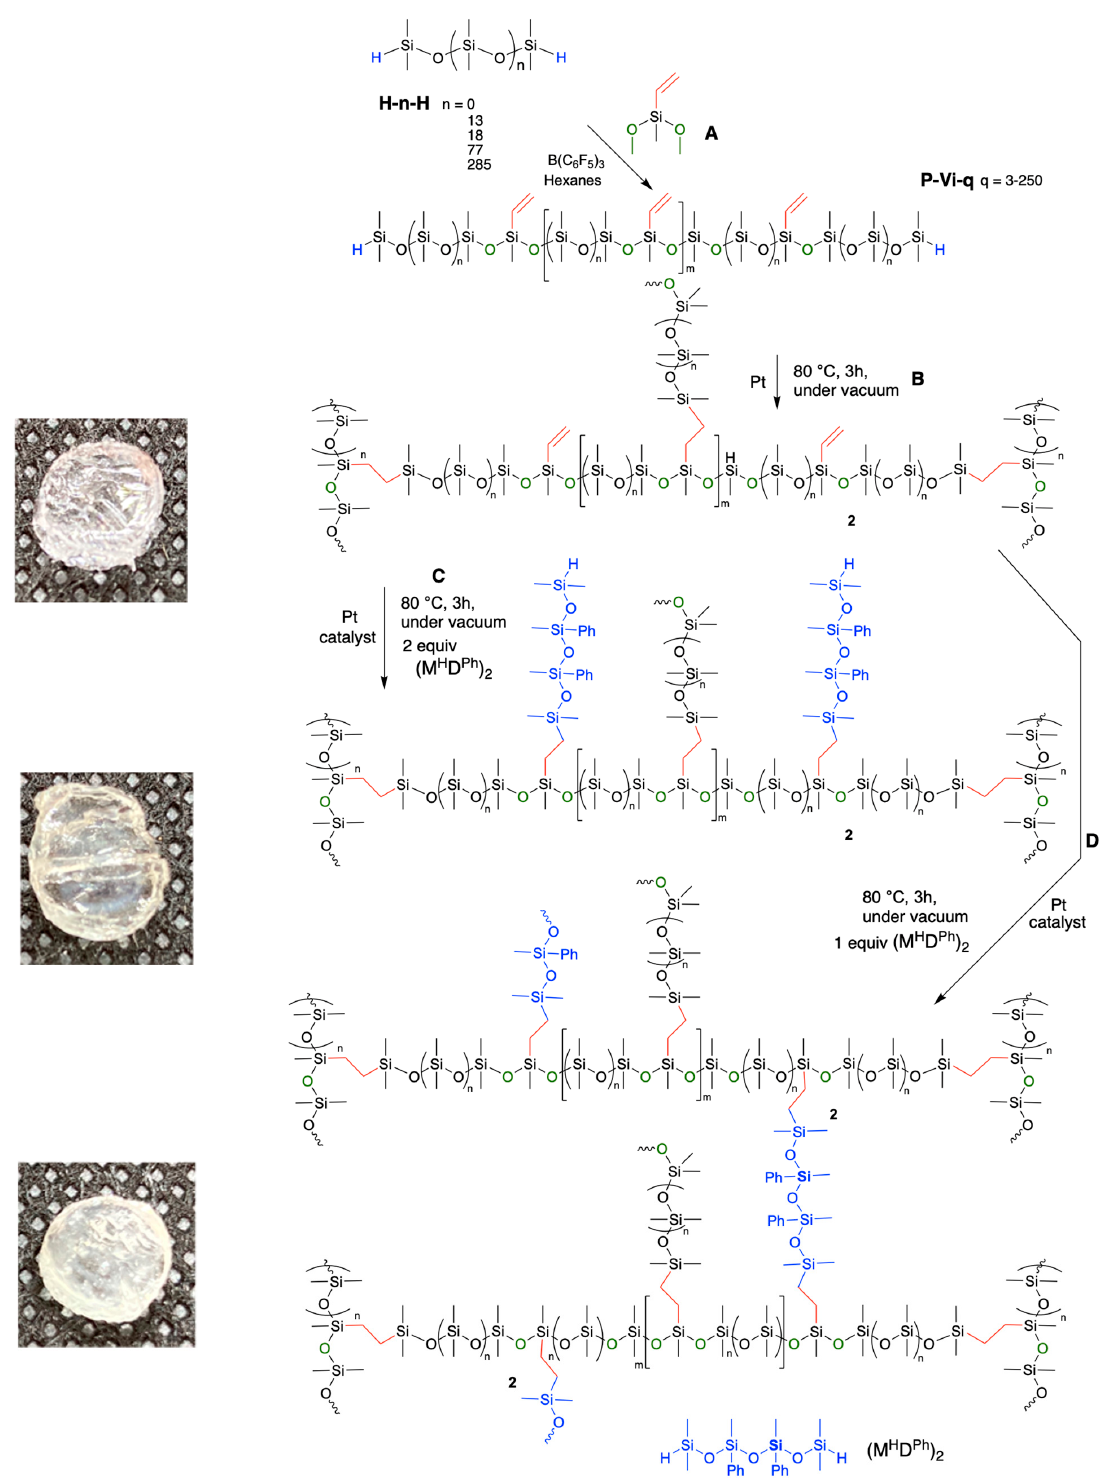
Figure 3. Synthesis of well-defined branched silicones using ( A ) Spatially controlled vinylsilicones using the Piers–Rubinsztajn reaction, shown for SiH terminated. ( B ) Self-curing of P-Vi-n . ( C ) Grafting of SiH branches using (M H D Ph ) 2 . ( D ) Crosslinking using (M H D Ph ) 2 .